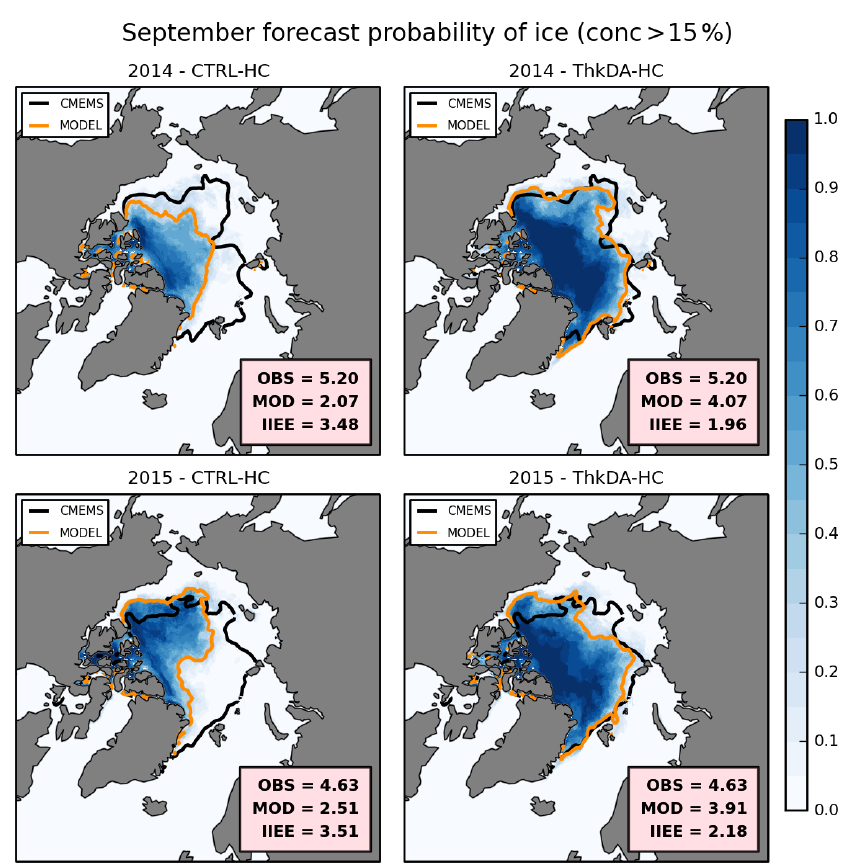
Figure 5. September mean probability of sea ice for the CTRL-HC (left) and ThkDA-HC (right) seasonal predictions for all years from 2011 (top) to 2015 (bottom). Contours of 15% concentration are overlain to represent the sea ice edge for the ensemble mean (orange) and CMEMS reanalysis product (black). Probability is defined at each point as the proportion of ensemble members that have at least 15% ice concentration. The CMEMS extent, modelled extent and corresponding Integrated Ice Edge Error (IIEE) are included, for each plot, in the lower-right corner (units: 10 6 km 2 )